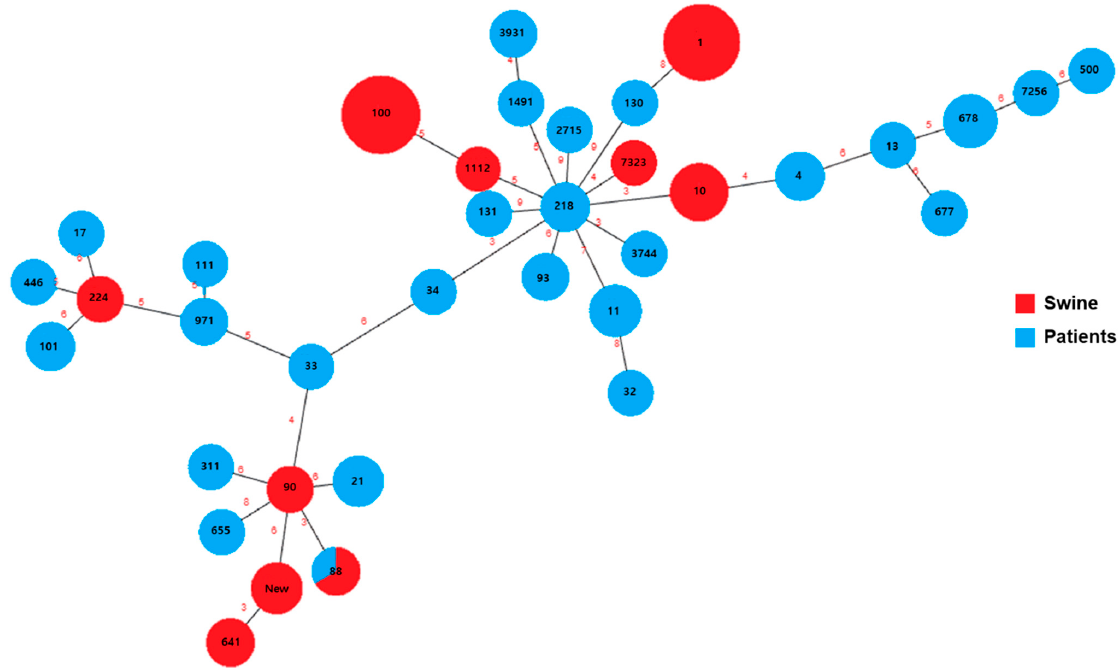
Figure 2. Minimum spanning tree based on sequence type of E. coli from pigs and patients. The divisions within each node are equal to the number of isolates belonging to the sequence type it represents. Black numbers in the circles indicate the MLST sequence type. Red numbers indicate the absolute distance between each sequence type. The node sizes vary linearly with the number of isolates of a given sequencing types.